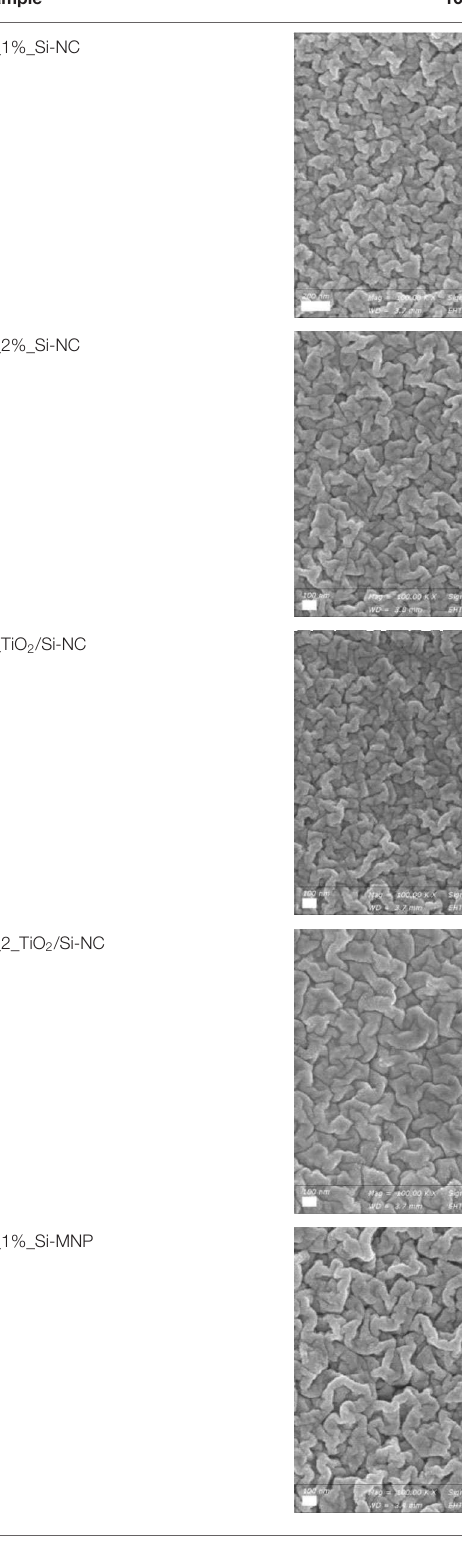
TABLE 3 | SEM micrographs at different magnification of the samples added with silica nanoparticles and silica nanoparticles and TiO 2 .